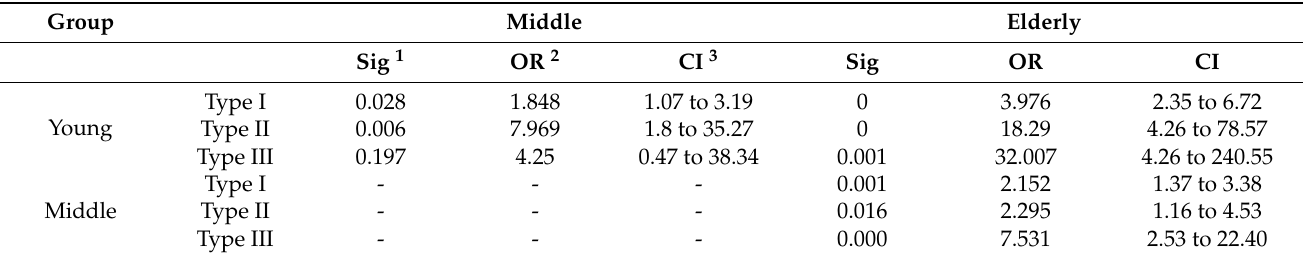
Table 2. Multivariate logistic regression result of qualitative analysis among three age groups. Group Middle